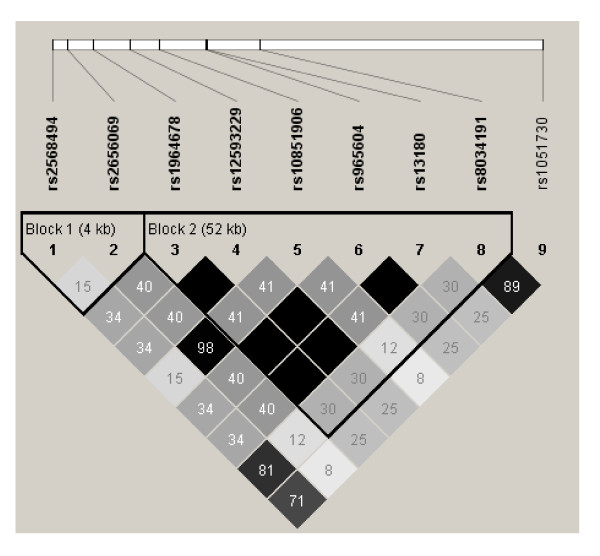
Linkage disequilibrium (LD) among SNPs analyzed in chromosome 15. LD values are presented as r2.